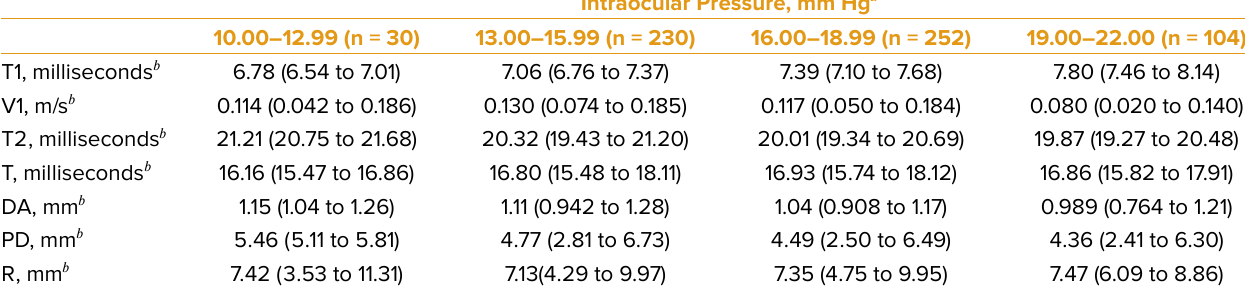
Table 6. Mean and normal range of Corvis parameters categorized based on the intraocular